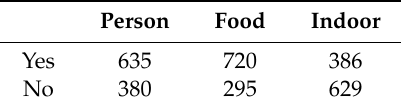
Table 2. Statistics of image content